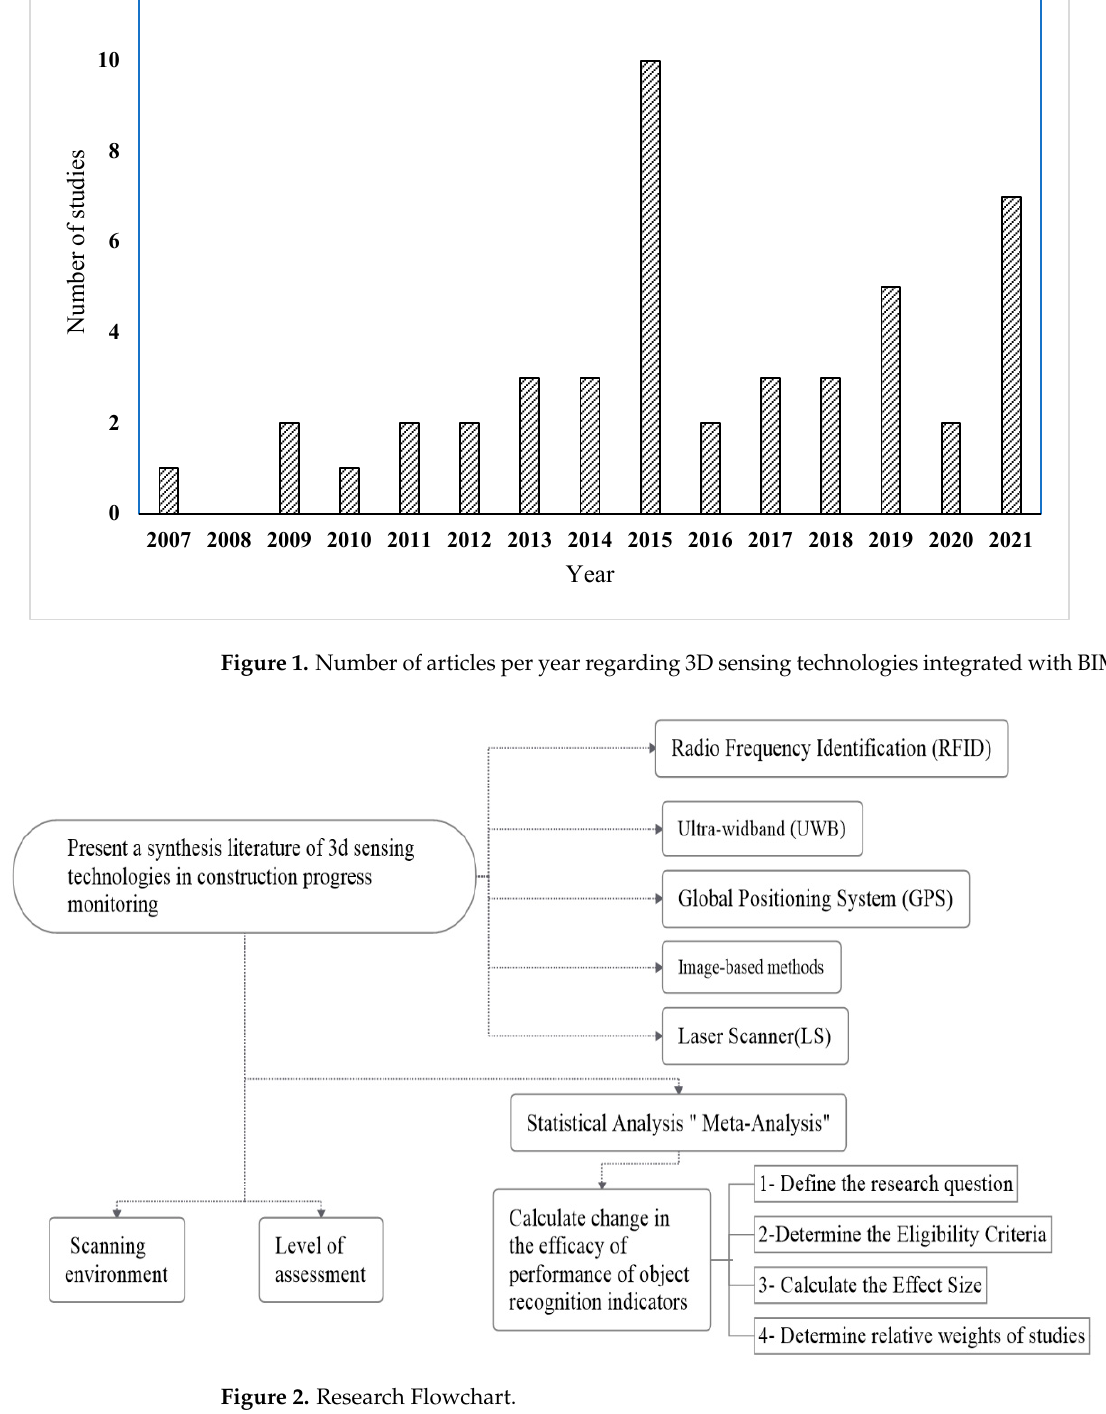
Figure 2. Research Flowchart.